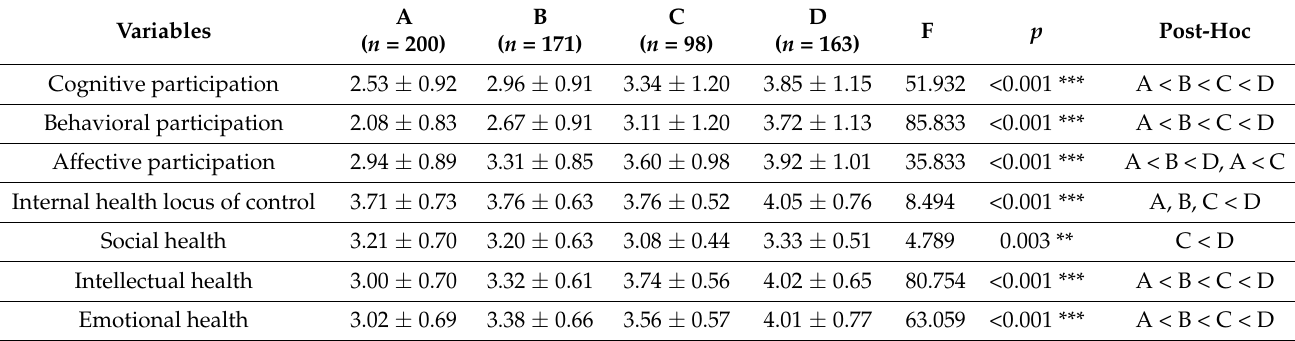
Table 9. Differences of each variable by the duration of sport